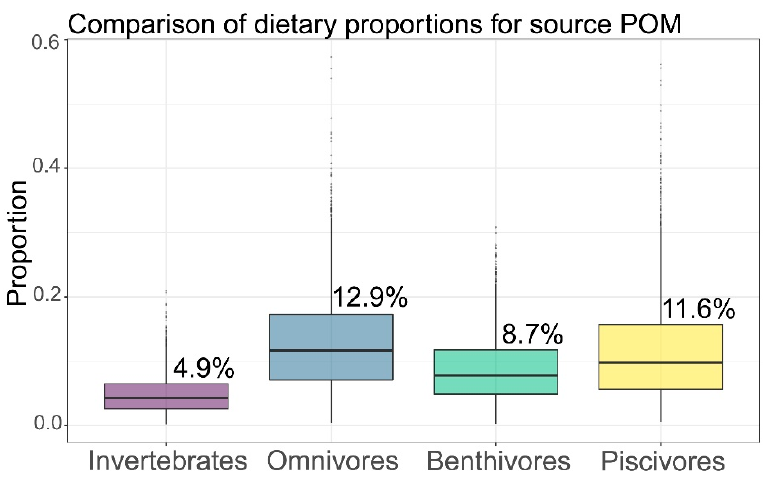
Figure 9. POM distribution for consumers in the sea area adjacent to the Miaodao Archipelago.